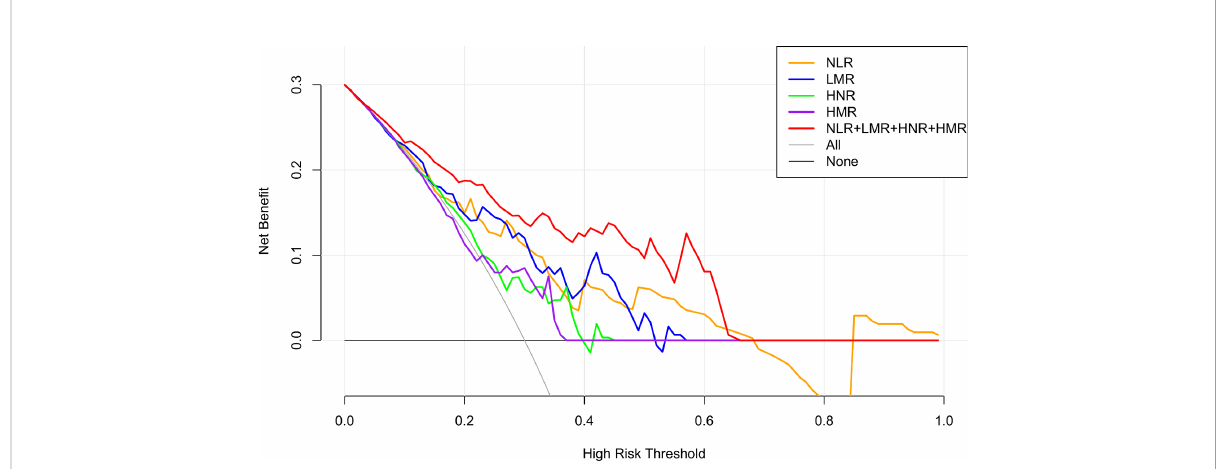
FIGURE 4 NLR, LMR, HNR, HMR and the clinical decision curve of NSCLC metastasis. (Note: the x-axis represents the threshold probability, the Y-axis represents the net bene fi t, the black line represents the assumption that all patients did not have metastases, and the gray line represents the assumption that all patients did have metastases).